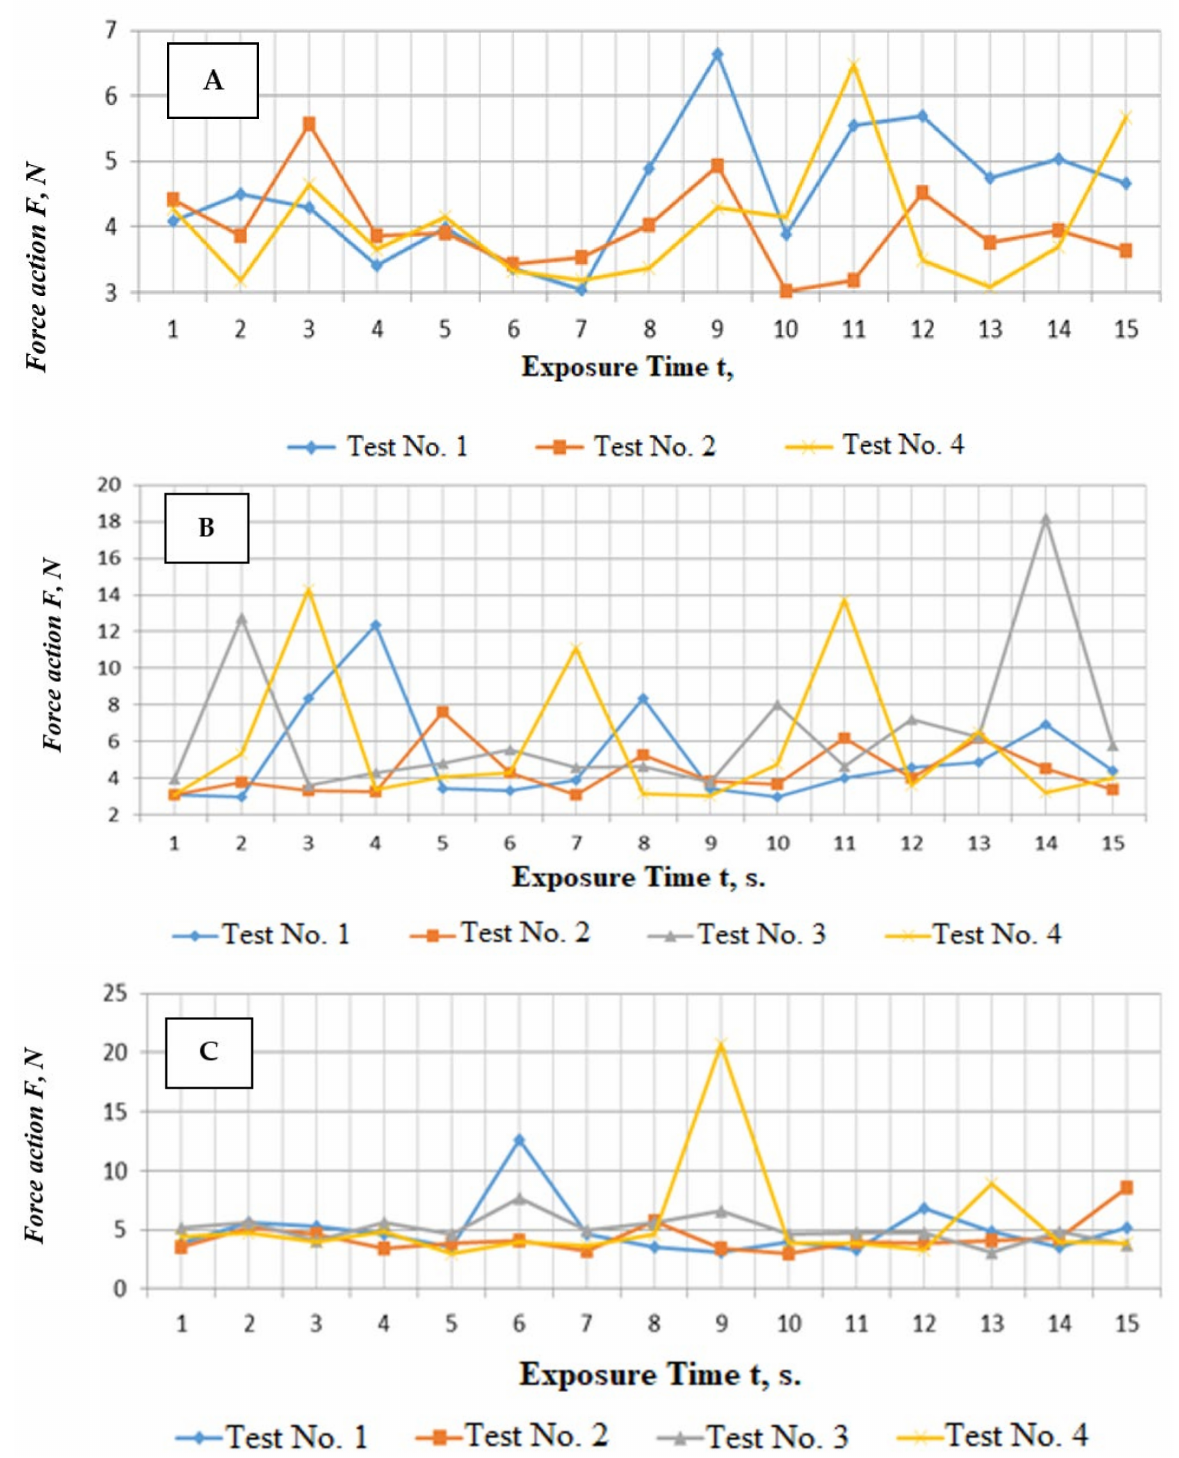
Figure 12. Force action of the work surface of the pin hummock on potato tuber: ( A )—annular travel speed of roller separating surface V EL = 3.6 km/h; ( B )—annular travel speed of roller separating surface V EL = 5.0 km/h; ( C )—annular travel speed of roller separating surface V EL = 6.4